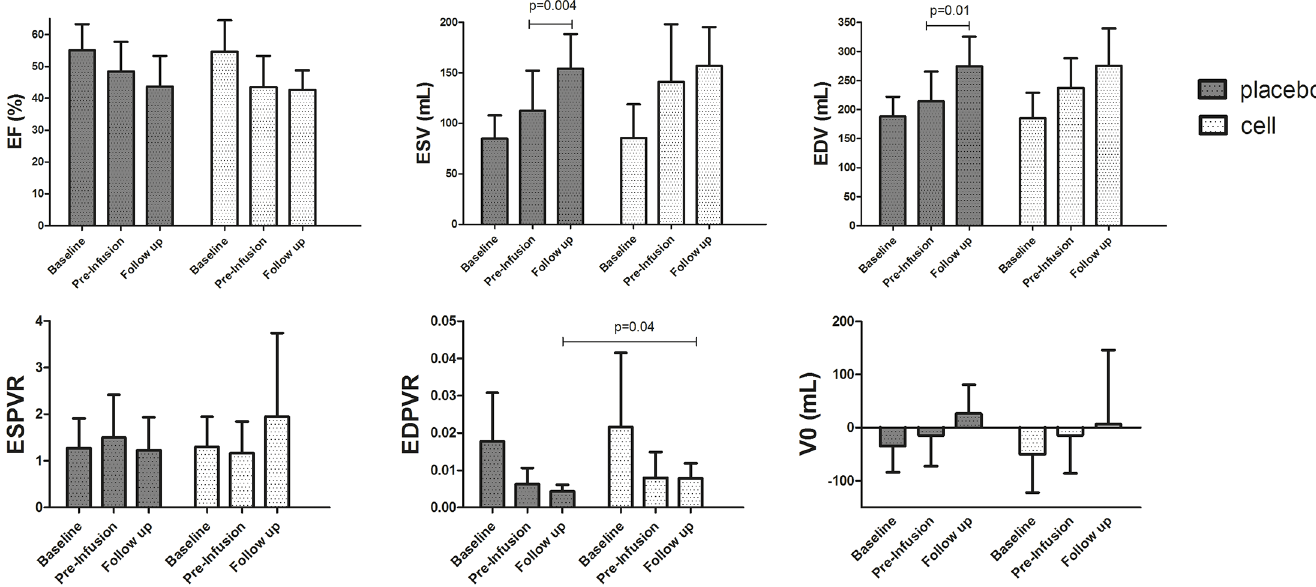
Fig 3. Functional outcome measurements by PV loop. Mean and SD for PVloop parameters. EDV End diastolic volume, ESV End systolic volume, EF Left ventricular ejection fraction, ESPVR End systolic pressures volume relationship, EDPVR end diastolic pressure volume relationship. Placebo n = 8, cell n = 7 for ESV, EDV and EF, n = 6 per group for ESPVR, EDPVR and V0.